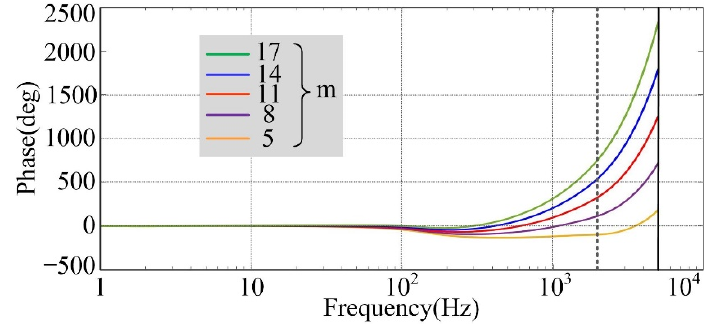
Figure 9. Bode diagrams of z m S ( z ) EP m ( z ) with different phase compensators.